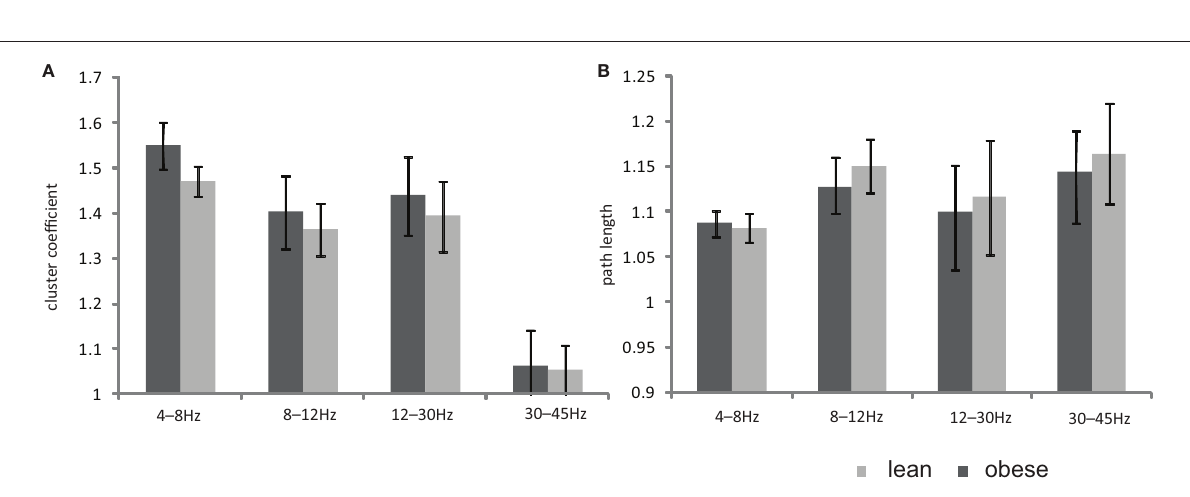
FiGurE 2 | Bar plot showing the mean values of (A) cluster coefficient (B) path length of the two baseline measurements for the lean and obese group. All data are given as mean ± SEM, * p <